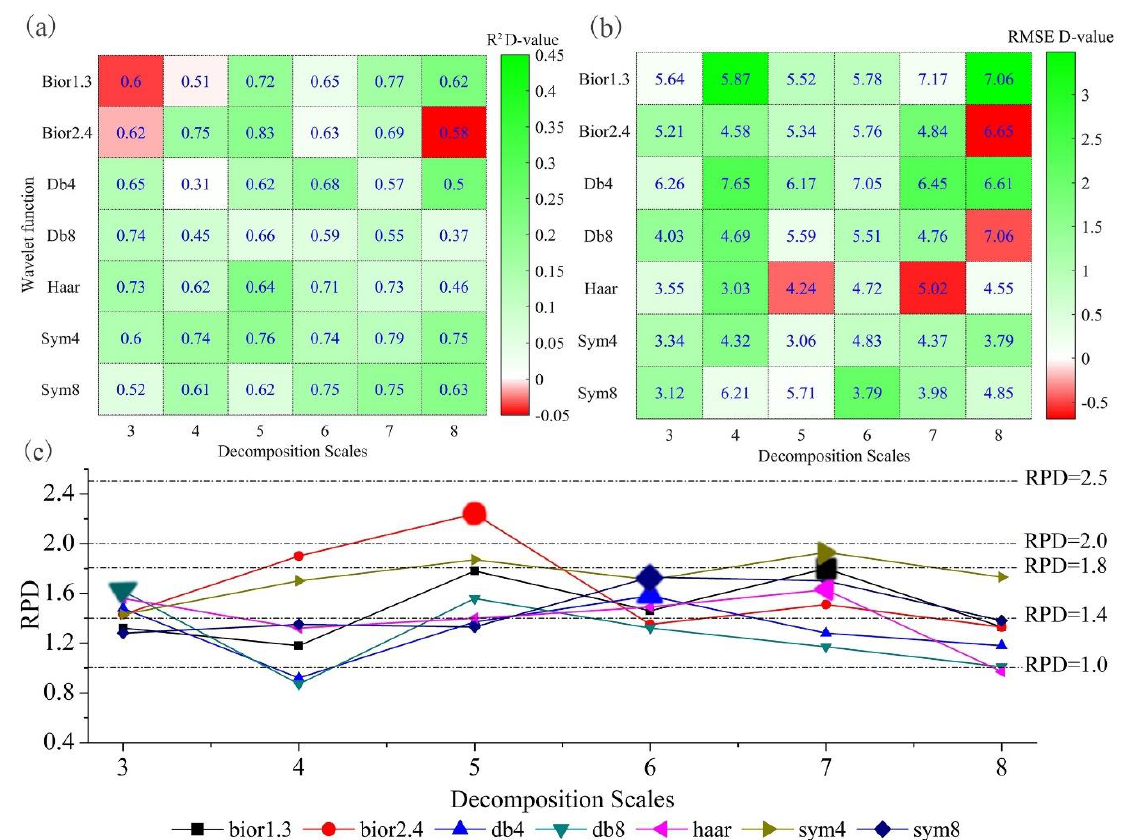
Figure 8. R v 2 (numbers in grid squares) and R 2 D-value (color bar) between DWT–Stepwise-PLS and DWT–PLS ( a ), RMSE (numbers in grid squares) and RMSE D-value (color bar) between DWT–Stepwise-PLS and DWT–PLS ( b ), and RPD between the laboratory-measured SOM and the DWT–Stepwise-PLS predictions on the SOM validation dataset ( c